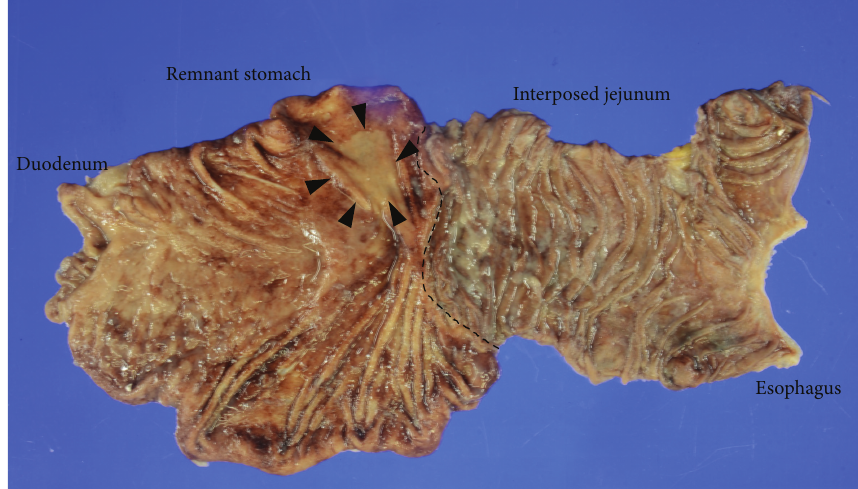
Figure 3: Resected specimen. The resected stomach contained a superficial depressed-type tumor, 37 × 17mm in size (black arrowhead). The black dote line showed the jejunogastrostomy at initial